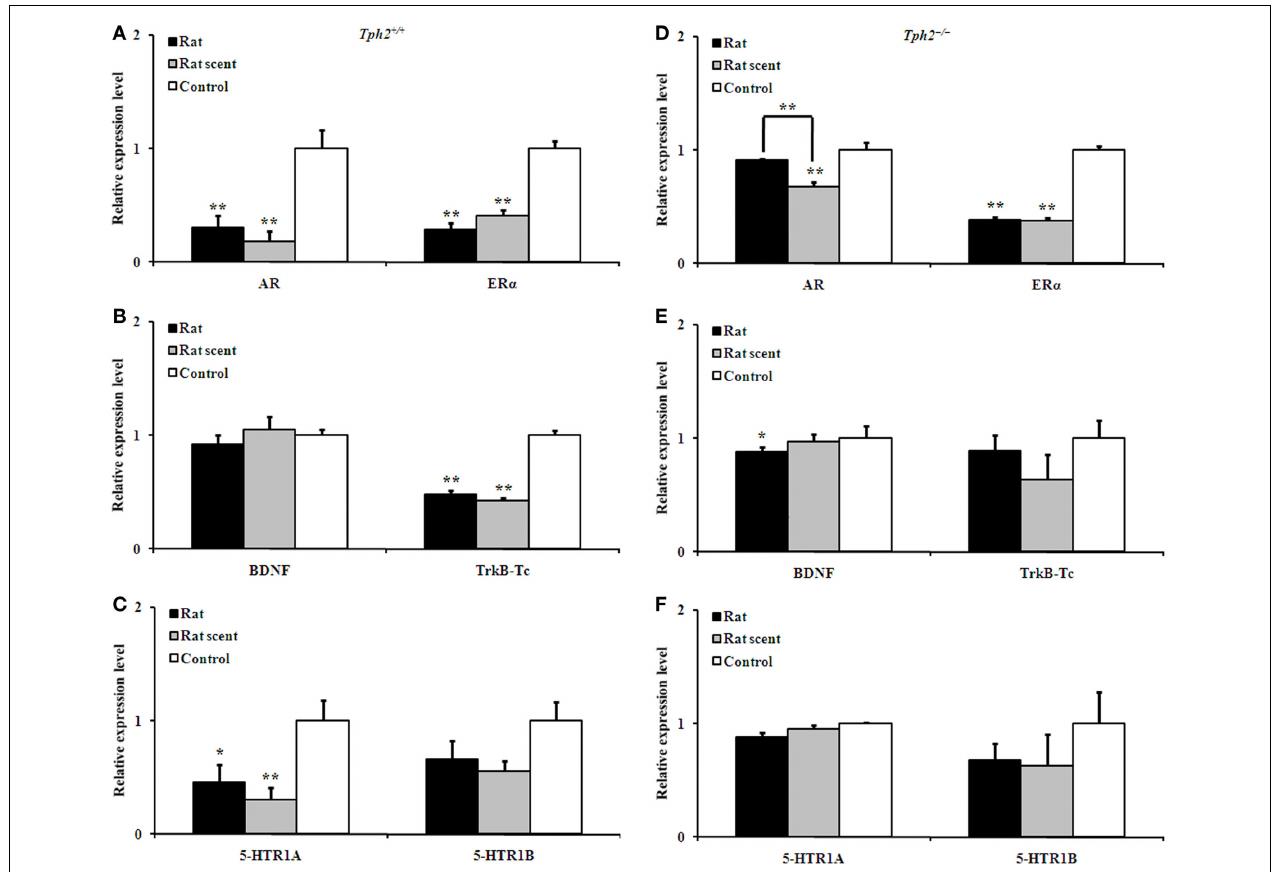
FIGURE 5 | Comparison of the relative expression of genes in the hippocampus of different groups. Expression patterns of AR and ER α (A) , BDNF and TrkB-Tc (B) , and 5-HTR1A and 5-HTR1B (C) in the hippocampus of the rat-exposed, rat scent-exposed and control Tph2 + / + male mice. Expression patterns of AR and ER α (D) , BDNF and TrkB-Tc (E) , and 5-HTR1A and 5-HTR1B (F) in the hippocampus of the